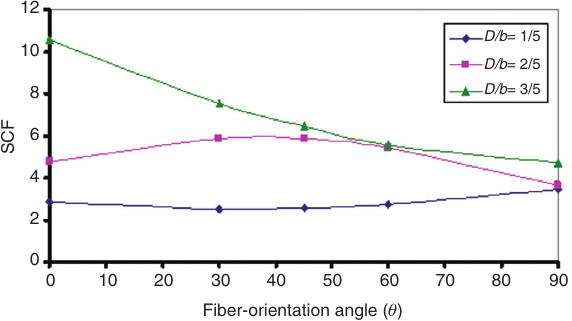
Figure 9 Effect of fiber orientation angle ( θ ) on SCF for a / b = 3 using graphite/epoxy